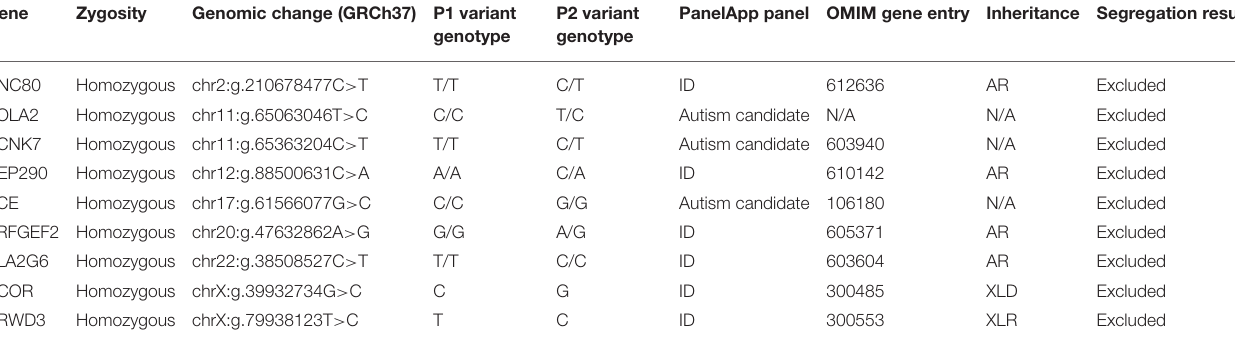
TABLE 2 | Rare homozygous variants in autism and/or intellectual disability- (ID-) associated genes identified in patient 1 whole-exome sequencing (WES). Gene